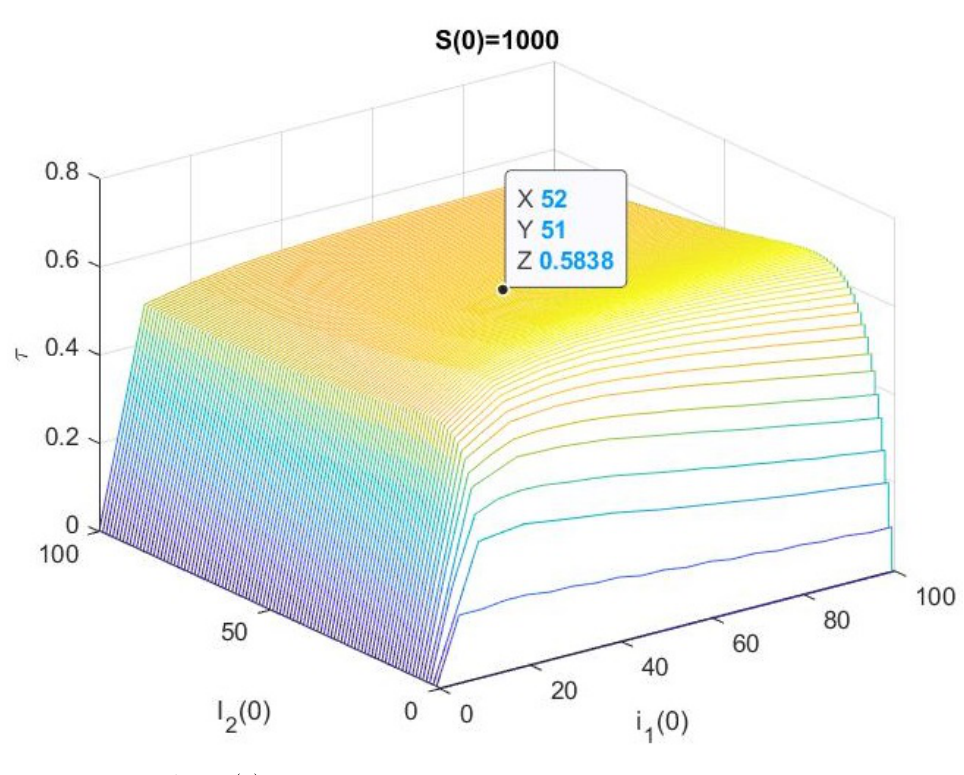
Figure 5. Example 3: S ( 0 ) = 1000